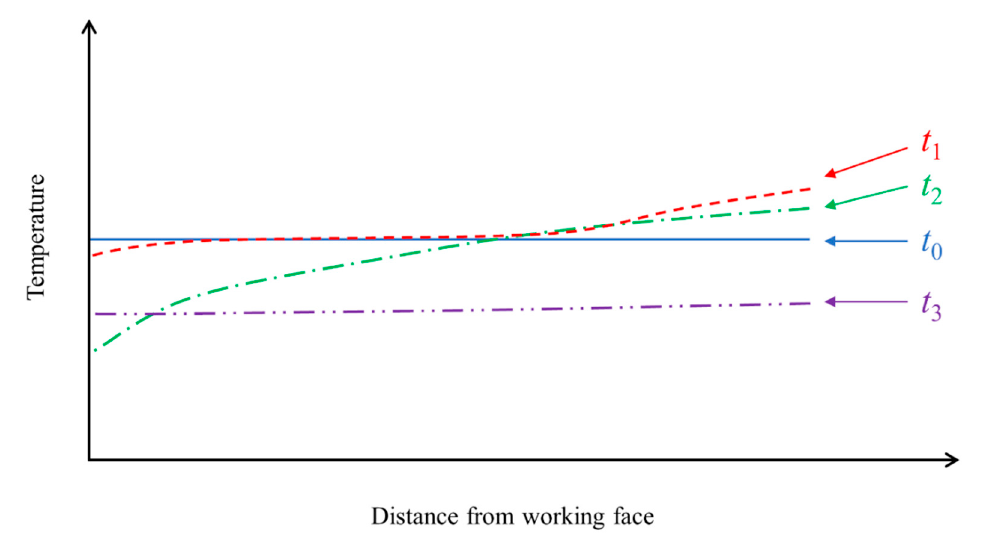
Figure 10. Dynamic evolution of the coal temperature at different locations.